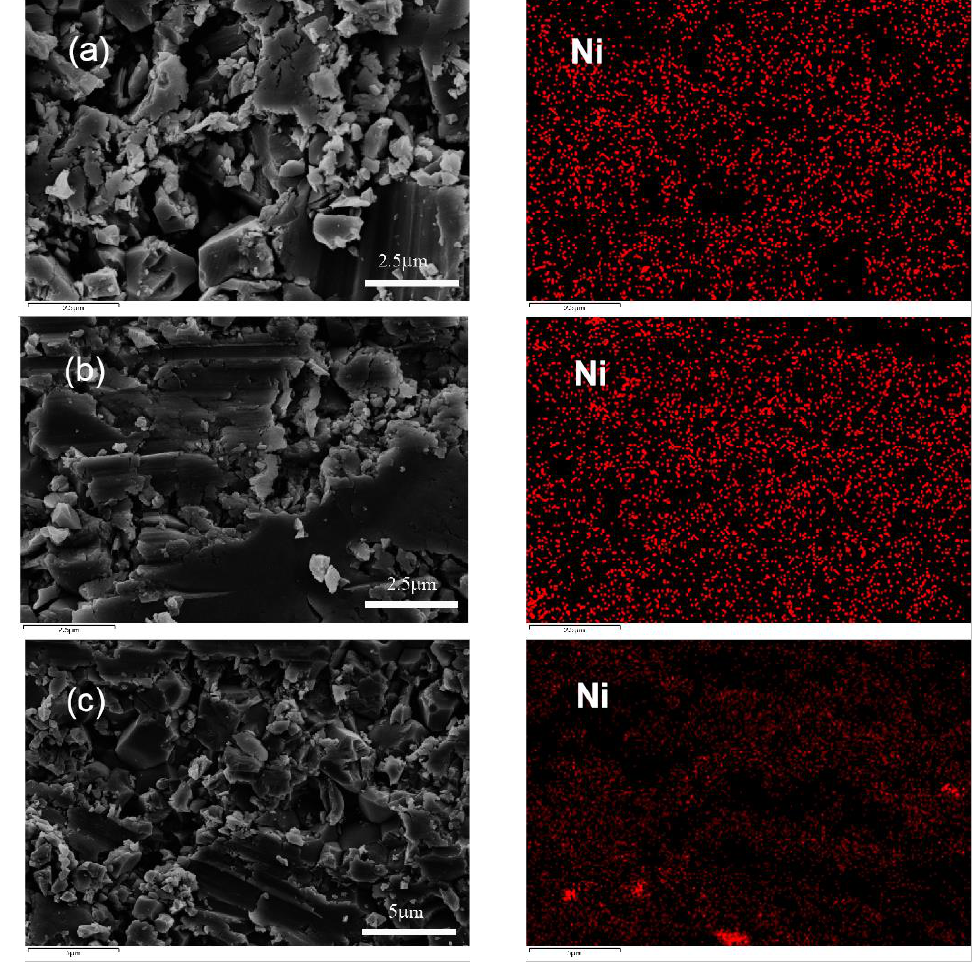
Figure 6. SEM-EDS mapping results for ( a ) 1 wt.% NiO internally doped LCNO, ( b ) 2 wt.% NiO internally doped LCNO and ( c ) 5 wt.% NiO internally doped LCNO.